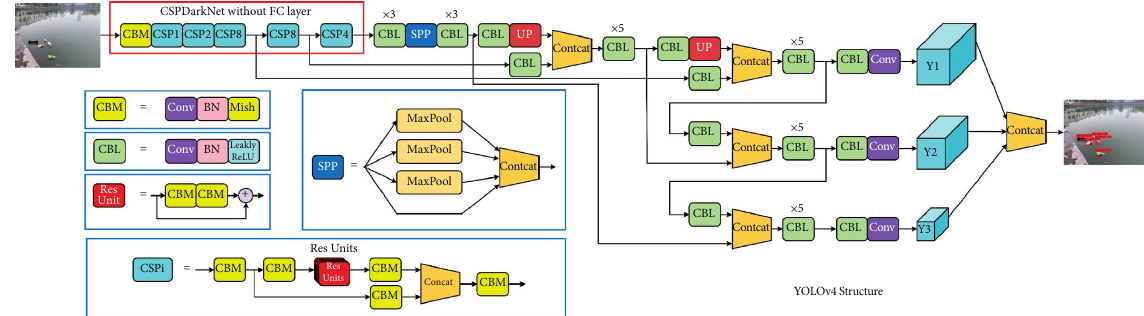
Figure 1: The garbage dataset, which contains 2000 color images in different scales, is developed for deep learning-based automatic detection of water-surface garbage. This current dataset is mainly composed of glass and plastic materials. More types of water-surface garbage will be incorporated into our dataset in the future